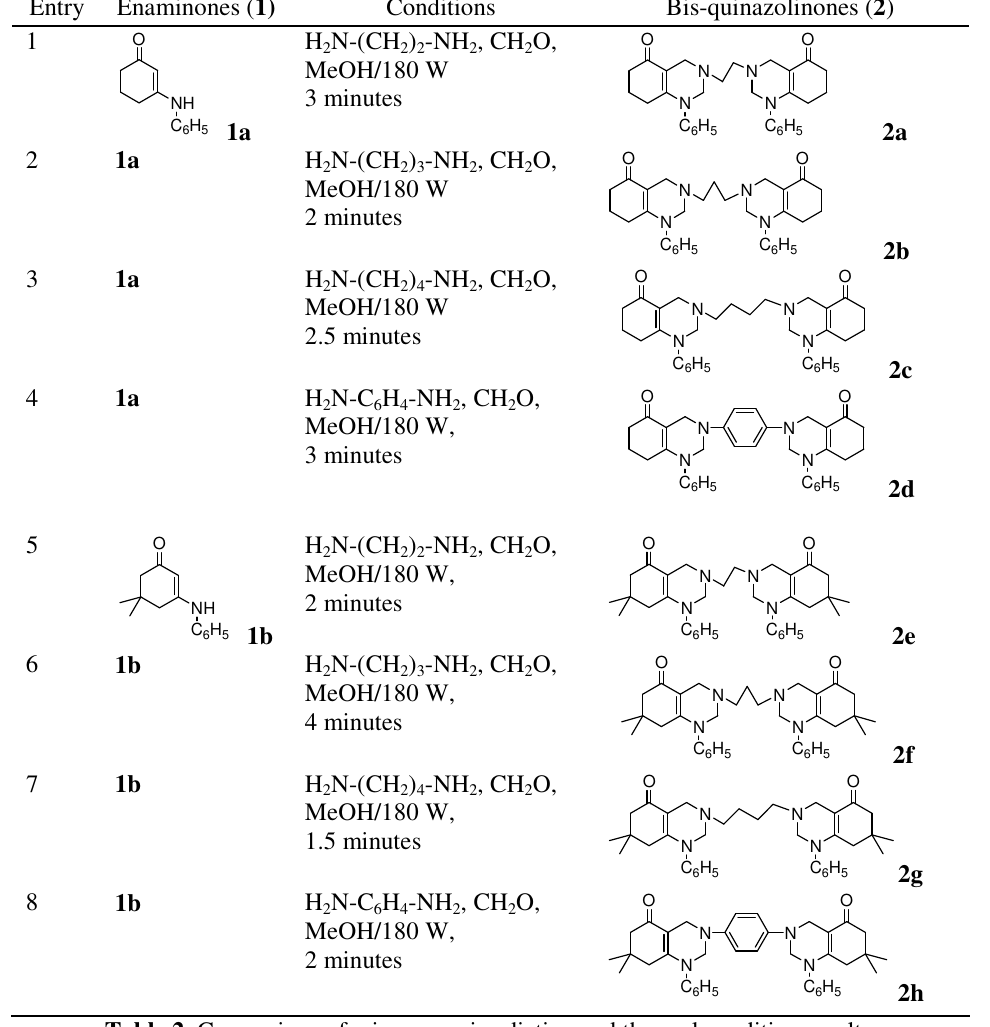
Table 1. Synthesis of bis-quinazolinones (2a-h)